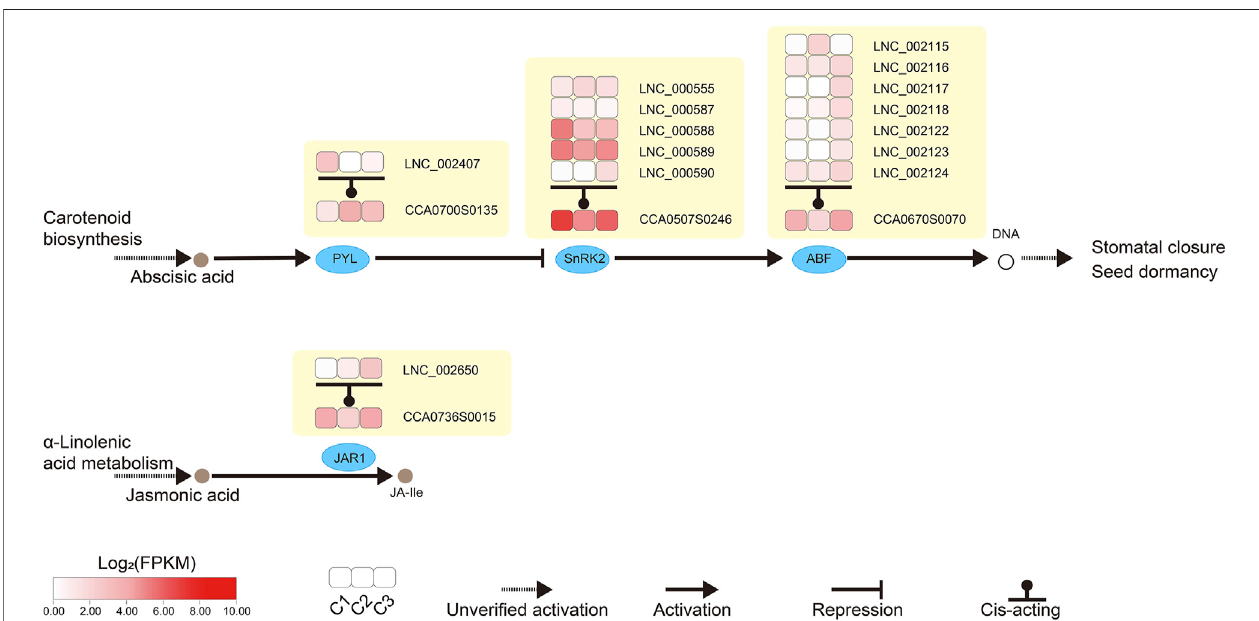
FIGURE 7 | Analysis of lncRNAs involved in the abscisic acid and jasmonic acid signaling transduction pathways of hickory female fl ower buds. Heat maps in the boxes showed the expression level of lncRNAs (lncRNA identi fi er) and the target genes (CCA identi fi er) of these lncRNAs. In the Carotenoid biosynthesis pathway, the secretion ofAbscisic acid promoted the expression of PYL , which in turn inhibited the expression of SnRK2 , which was positively correlated with the expression of ABF . All three genes were regulated by lncRNA cis-acting, thereby affecting Stomatal closure and seed dormancy. In the α -Linolenic acid metabolism pathway, the production of JA-ile from jasmonic acid was affected by JAR1 , which was also regulated by lncRNA in cis-acting. CCA, Carya cathayensis ; ABF, ABRE-binding factor; JAR1, JASMONATE RESISTANT 1; PYL, Pyrabactin resistance-like; SnRK2, SNF1-related protein kinase 2.